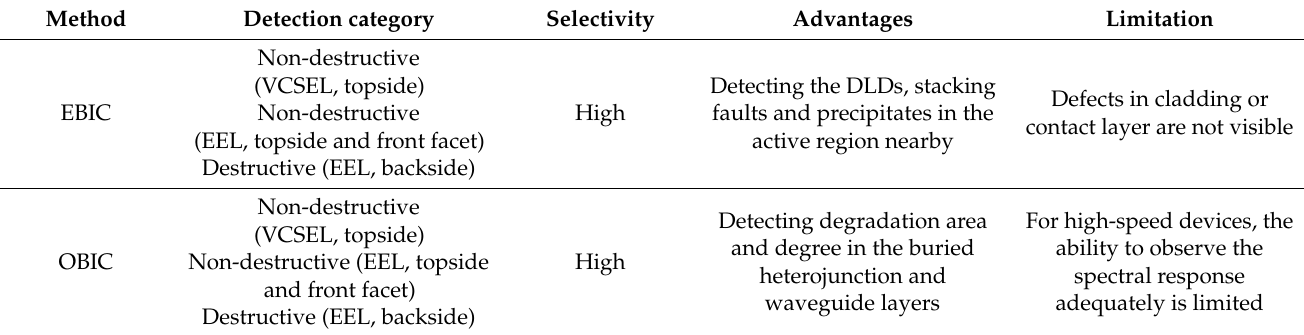
Table 2. Comparison of various detection